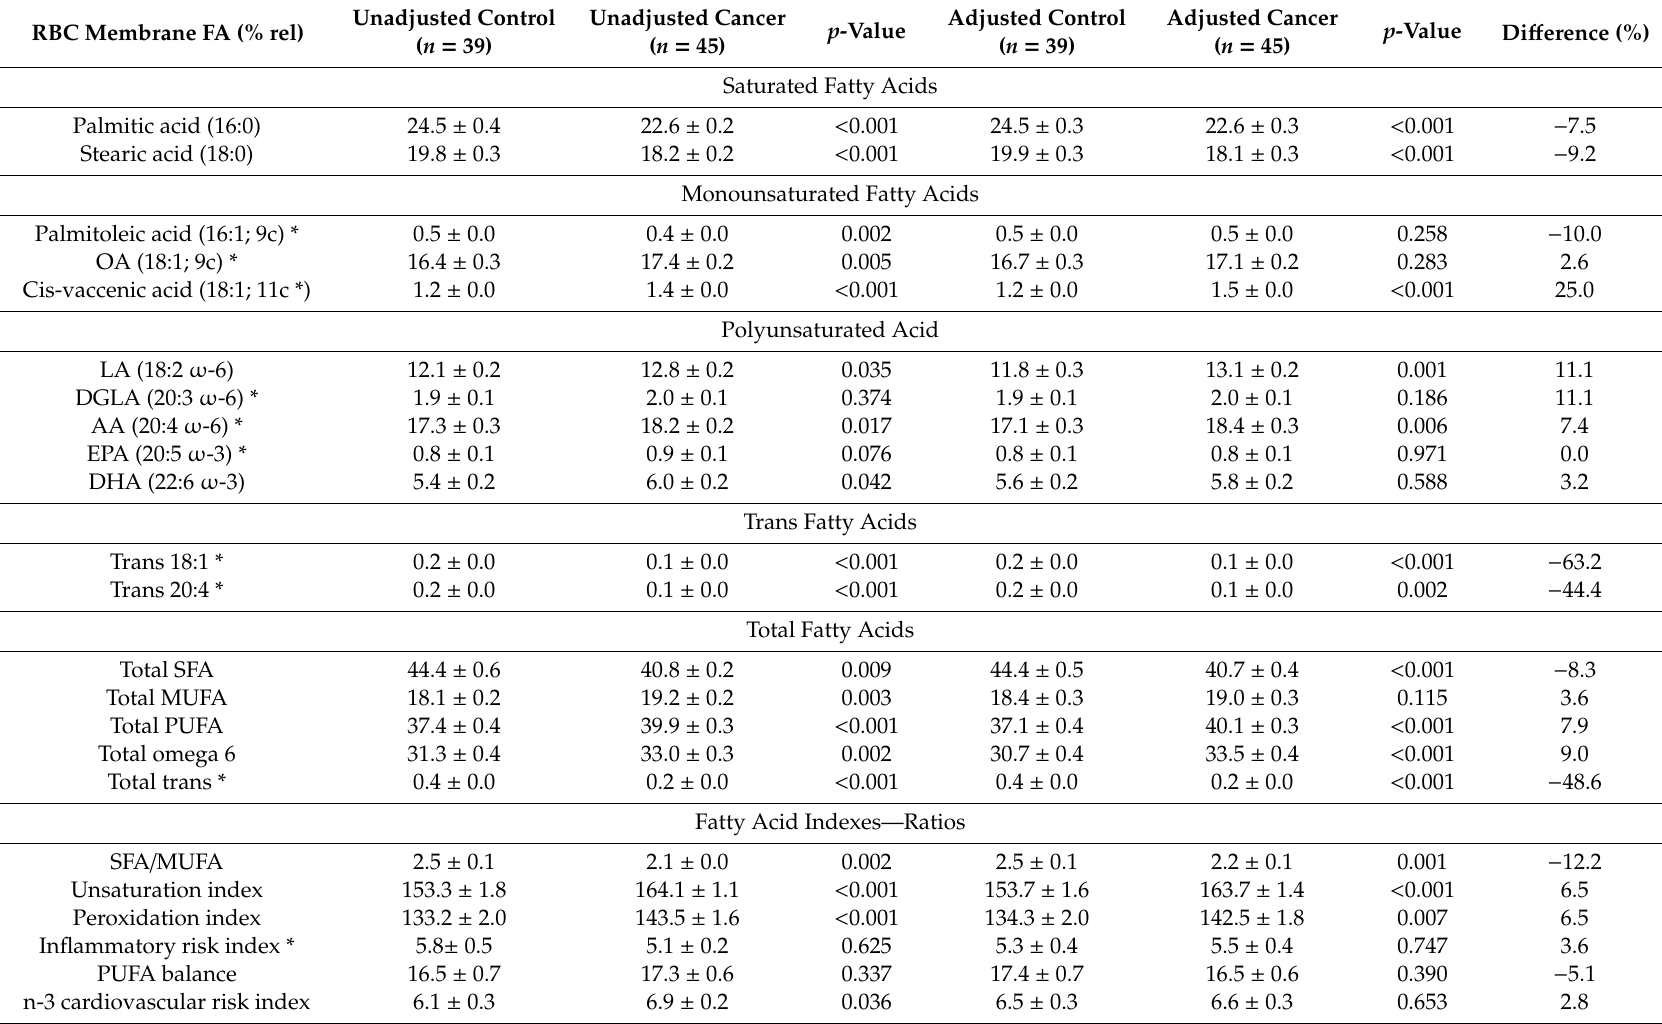
Table 2. Red blood cell (RBC) membrane fatty acid (FA) levels in cancer and control